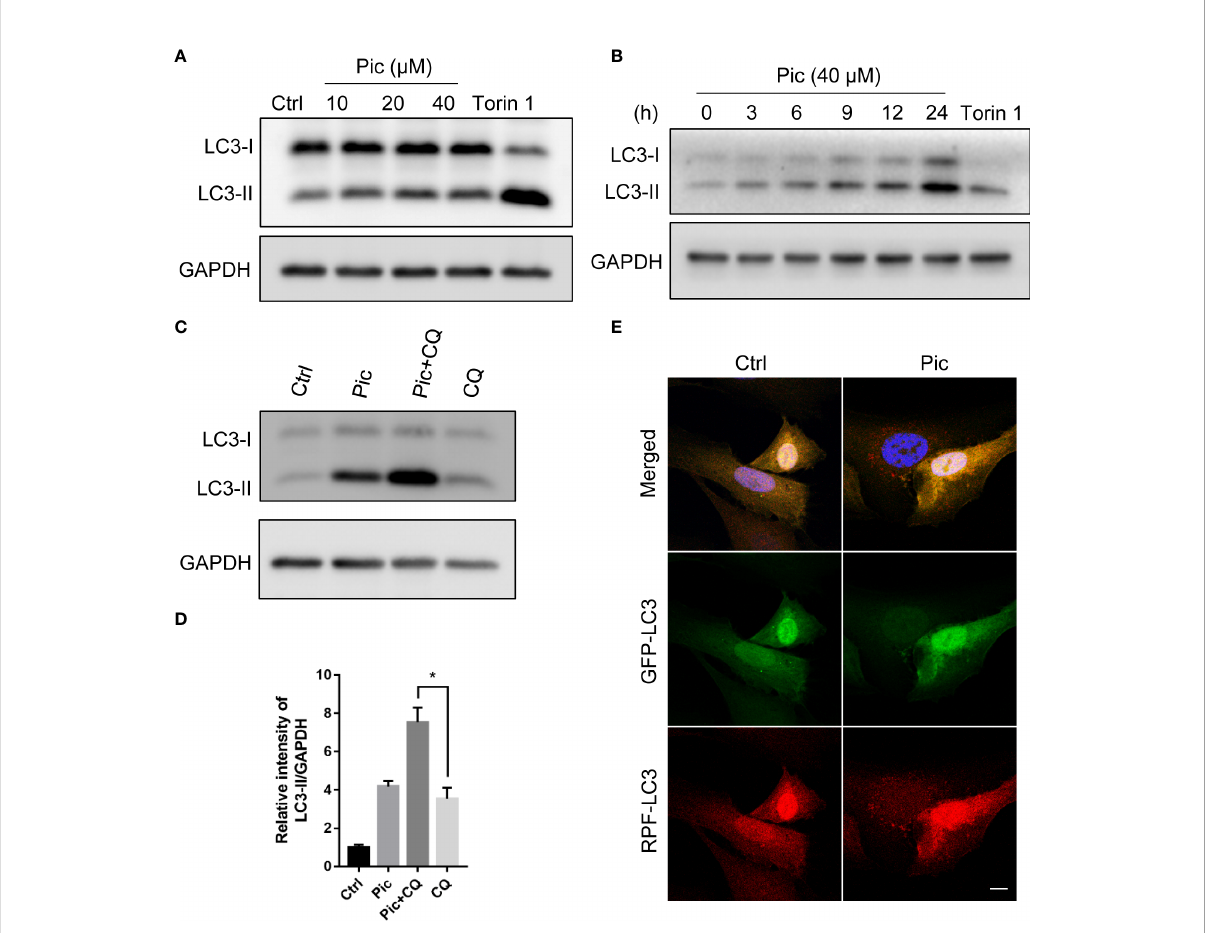
FIGURE 1 Piceatannol promotes autophagy fl ux. (A) Piceatannol (Pic) dose-dependently increases LC3-II levels. U2OS cells were treated with indicated concentration of Pic for 24 h, the expression of autophagy marker LC3-II was examined. (B) Pic time-dependently increases LC3-II levels. The expression of LC3-II was examined after treating cells with 40 µM Pic for indicated durations in U2OS cells. (C, D) Pic (40 µM) further increases LC3-II levels when in combination with lysosomal inhibitor chloroquine (CQ). (E) Pic increases autolysosomes. After transfected tf-LC3 plasmid into cells for 48 h, cells were incubated with Pic (40 µM) for another 24 h, the green and red-only puncta was examined by a fl uorescence microscope (E) . Scale bar: 10 µm. Error bars indicate SEM for at least three biological replicates. Student-t test was used for statistical analysis. * p -value <